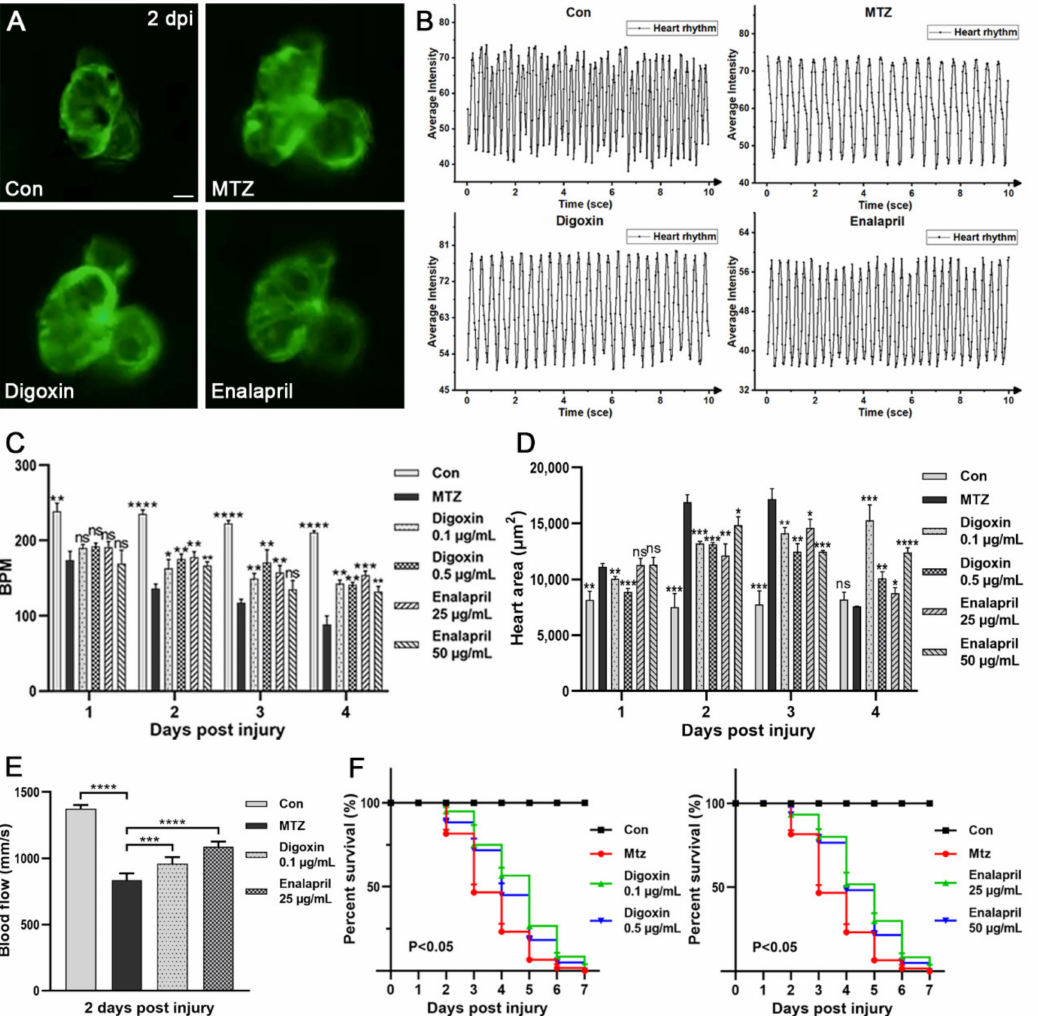
Figure 6. Evaluation of the effect of digoxin and enalapril on the CRS-3 model. ( A ) Heart images of zebrafish larvae (Control, zebrafish larvae treated with MTZ, zebrafish larvae treated with digoxin or enalapril) ( n = 5) at 2 dpi are shown. Scale bar: 100 µ m. ( B , C ) Heart rate was detected by the dynamic change pattern in the ventricle of zebrafish larvae. ( D ) ARF-induced heart enlargement can be decreased by digoxin and enalapril ( n = 5). ( E ) Compared with the control group, treatment of ARF larvae with digoxin and enalapril resulted in significant increases in blood flow velocity ( n = 5). ( F ) After treatment with digoxin or enalapril, the survival rate of ARF zebrafish larvae was increased ( n = 60). Mean ± SEM; ns, not significant; * p < 0.05, ** p < 0.01, *** p < 0.001, and **** p < 0.0001, ANOVA/Dunnett’s test compared with untreated ARF zebrafish